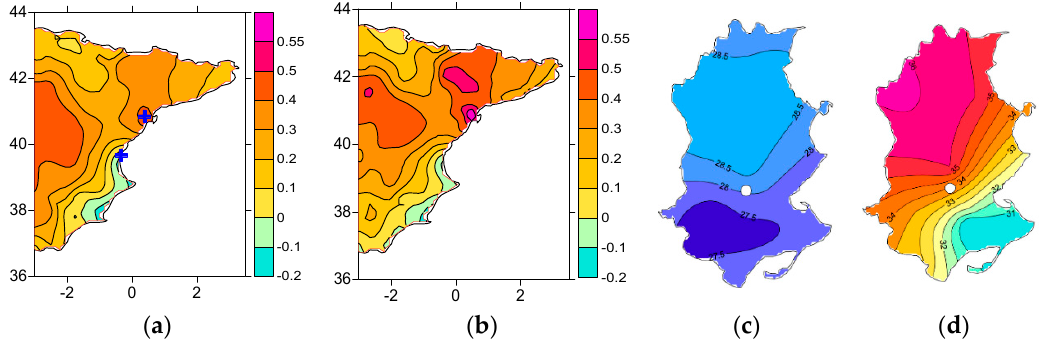
Figure 4. ( a ) Daily correlations between Tx and PC2 (top blue cross—Ebro Observatory, bottom blue cross—Valencia Observatory); ( b ) Daily correlations between DTR and PC2; ( c ) Average value of maximum temperatures in lower Ebro Valley (PC2 < 10th percentile) (1996–2006); ( d ) Average value of maximum temperatures in lower Ebro Valley (PC2 > 90th percentile) (1996–2006). White point indicates the location of the Ebro Observatory, to the NW of the Ebro delta.